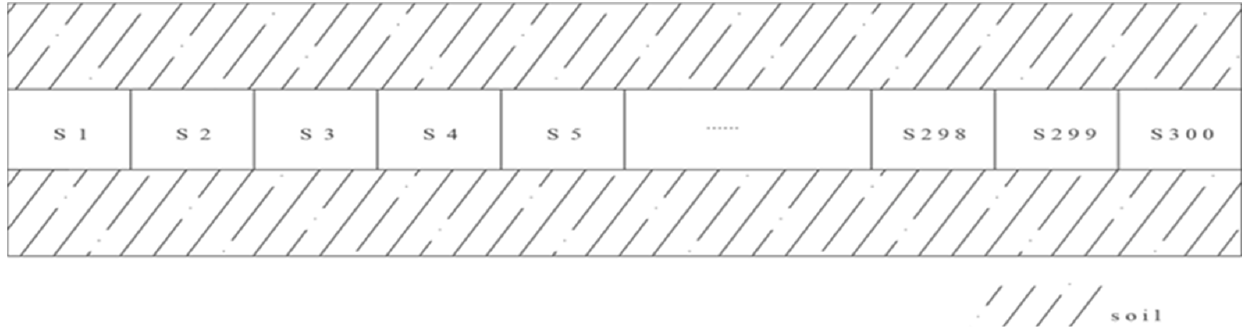
Figure 7. Segment of the finite element model .